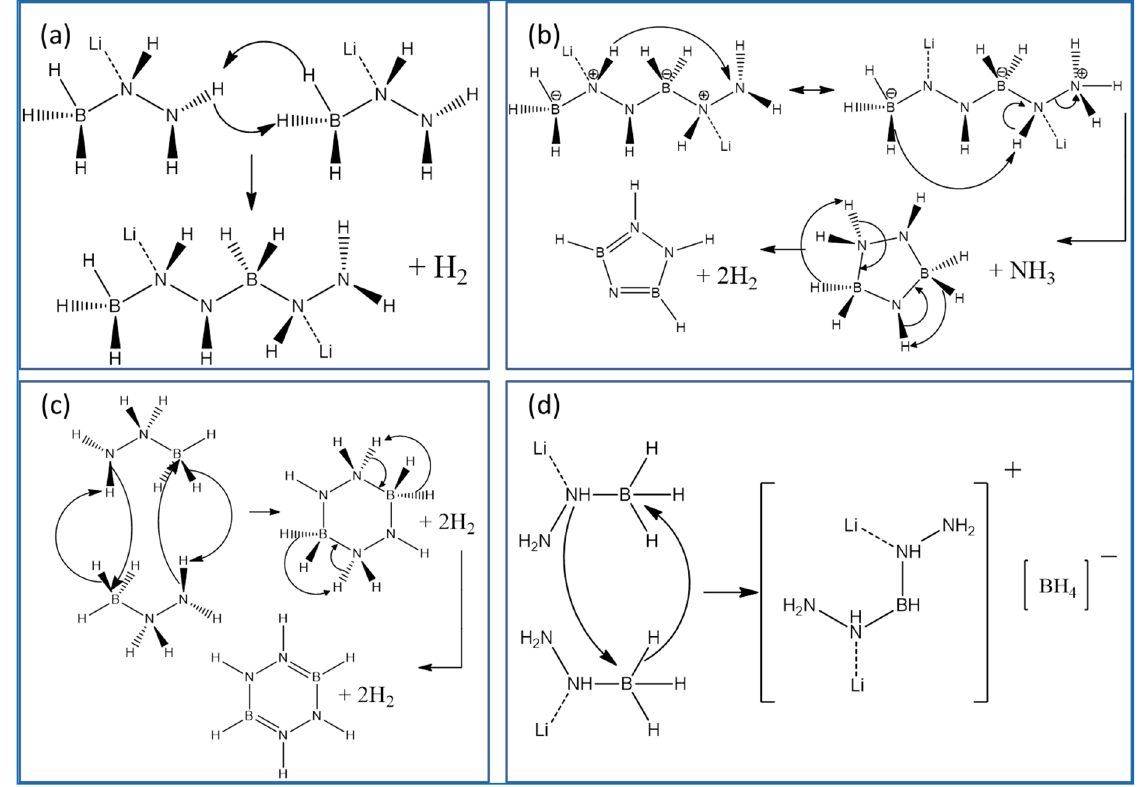
Figure 8. Proposition of mechanisms for the formation of monomeric units and bis (lithium hydrazide) of diborane [(LiN 2 H 3 ) 2 BH 2 ] + [BH 4 ] − . ( a ) Linear dimer with boron in sp 3